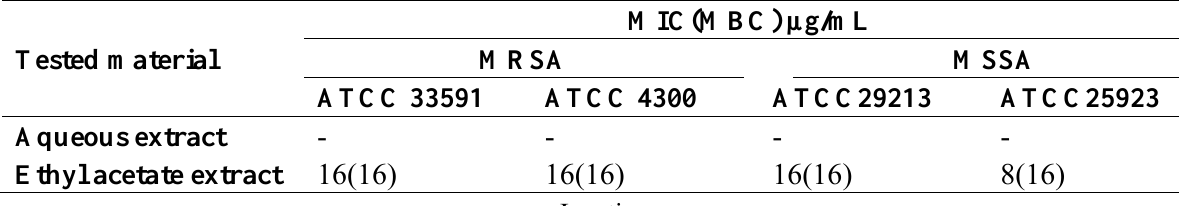
Table 1. Minimal inhibitory concentration (MIC) and minimal bactericidal concentration (MBC) of extracts of leaves of P. regnellii against methicillin-sensitive S. aureus (MSSA) and methicillin-resistant S. aureus (MRSA).